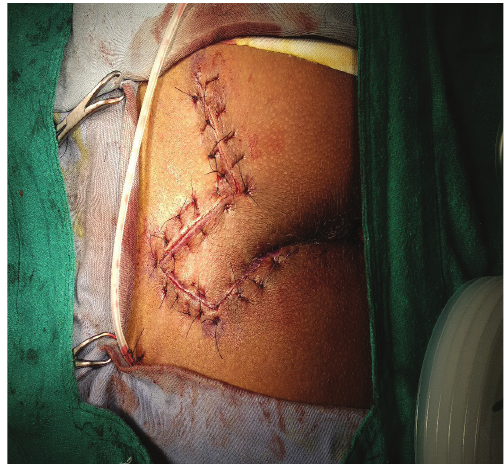
Figure 4 : The flap is rotated to cover midline rhomboid defect